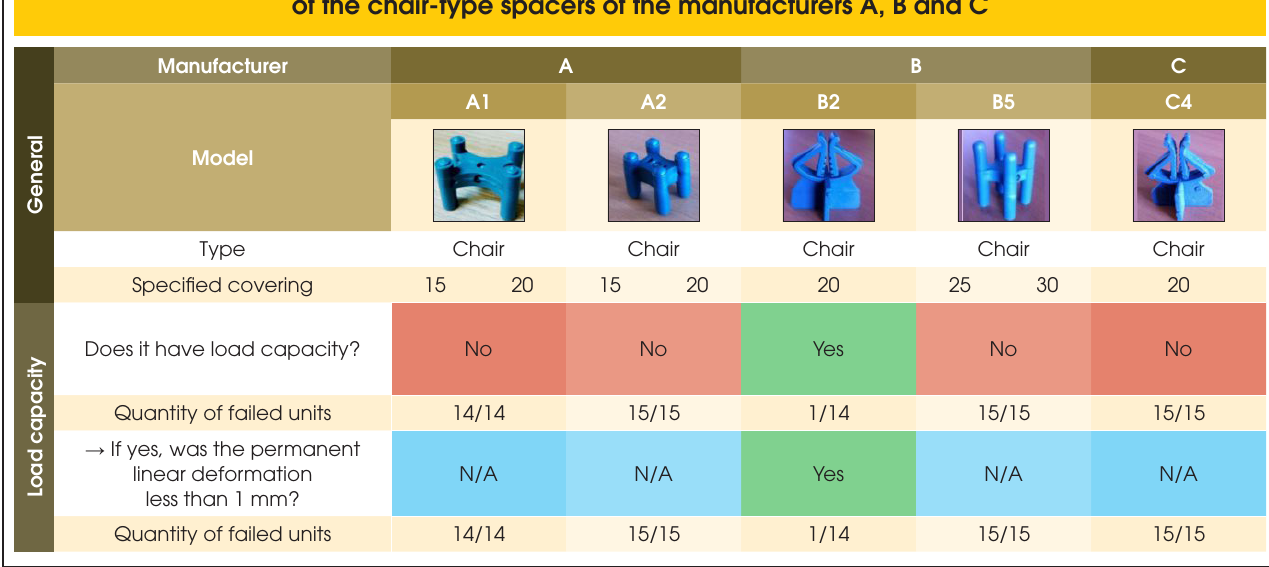
Table 18 – Results of the load capacity requirement evaluation of the chair-type spacers of the manufacturers A, B and